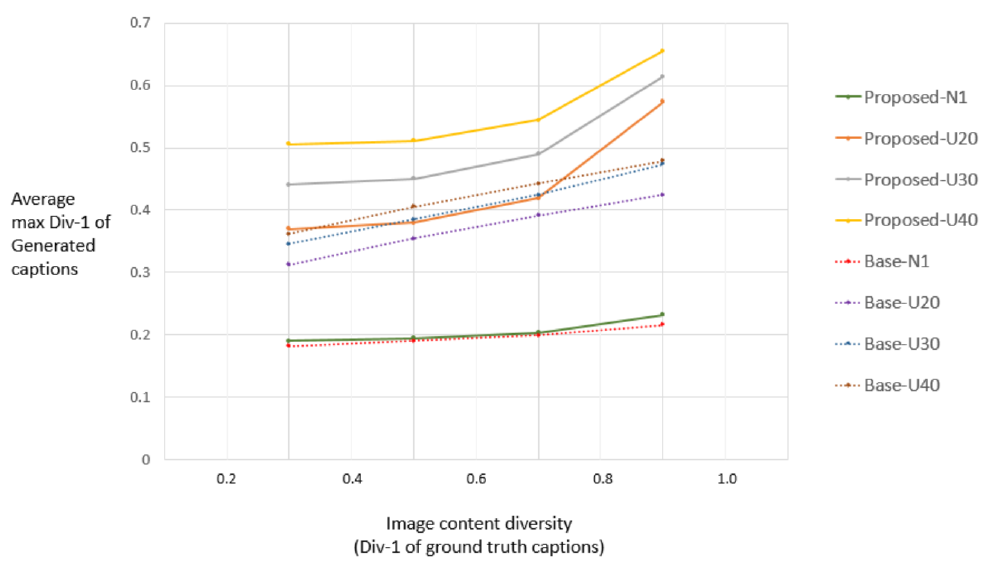
Figure 4. Representation of the relationship between the image content diversity and the diversity of captions generated. As the image-content diversity increases, the Div-1 value of the proposed model increases more rapidly than with the base